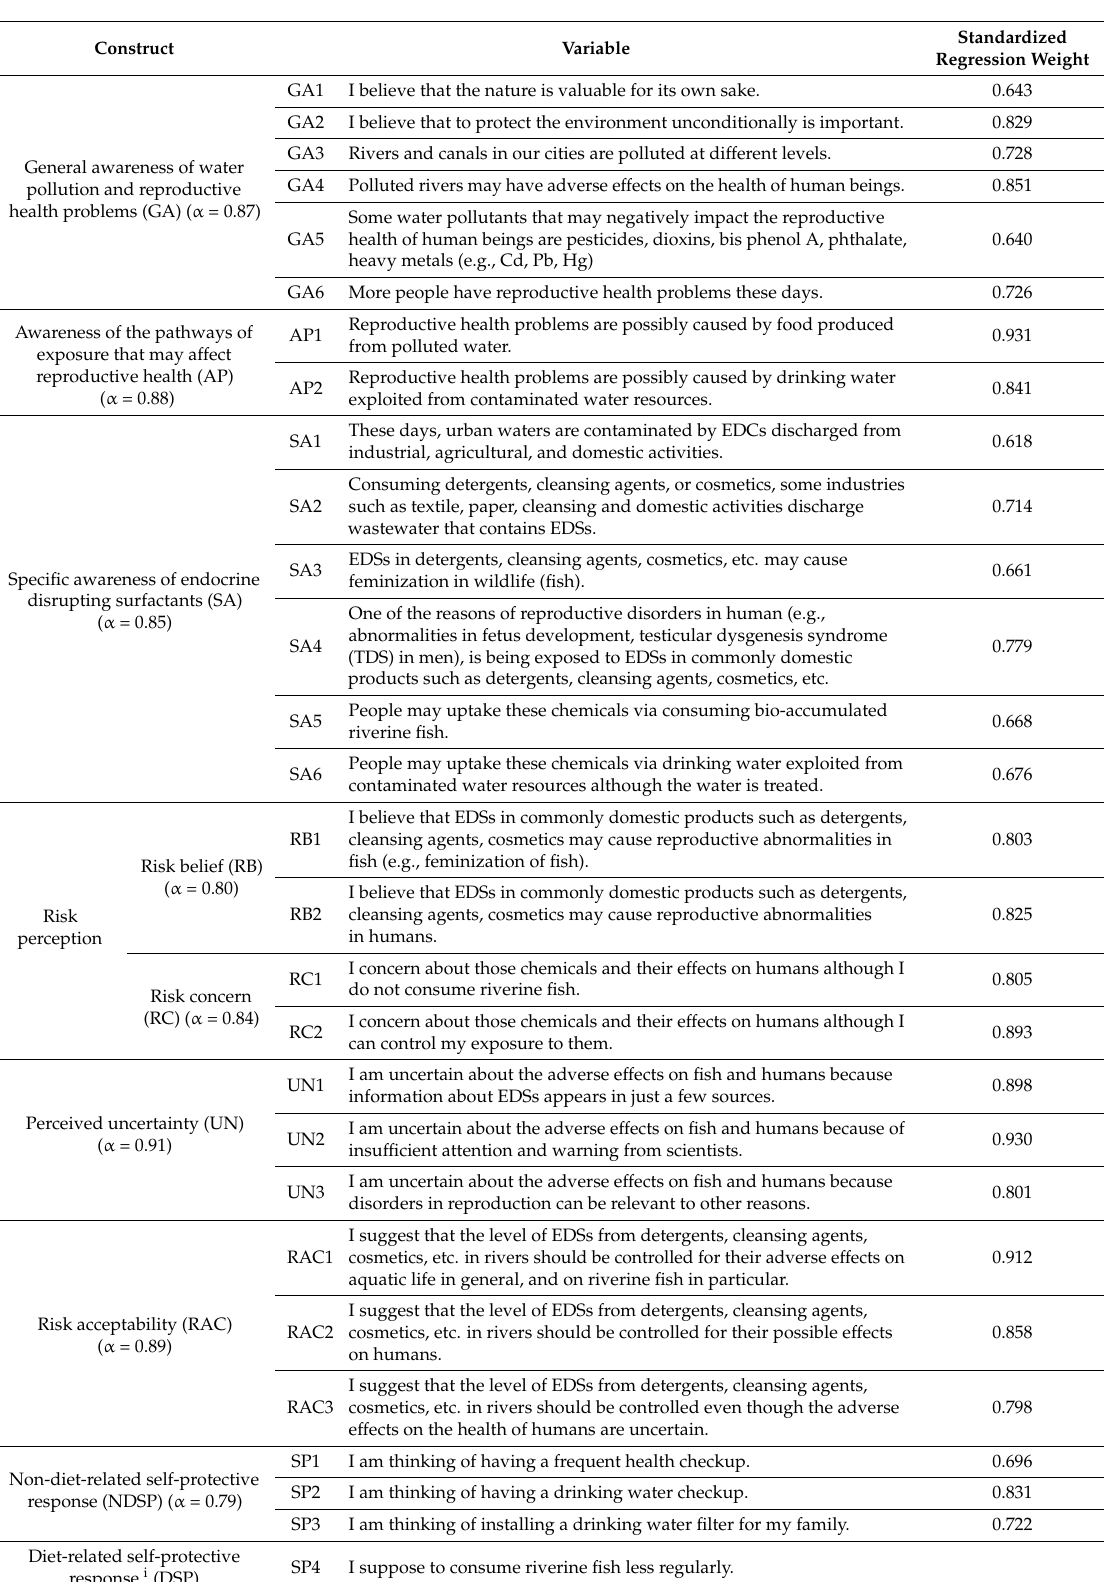
Table 1. Alpha coefficients and factor loadings ( n =